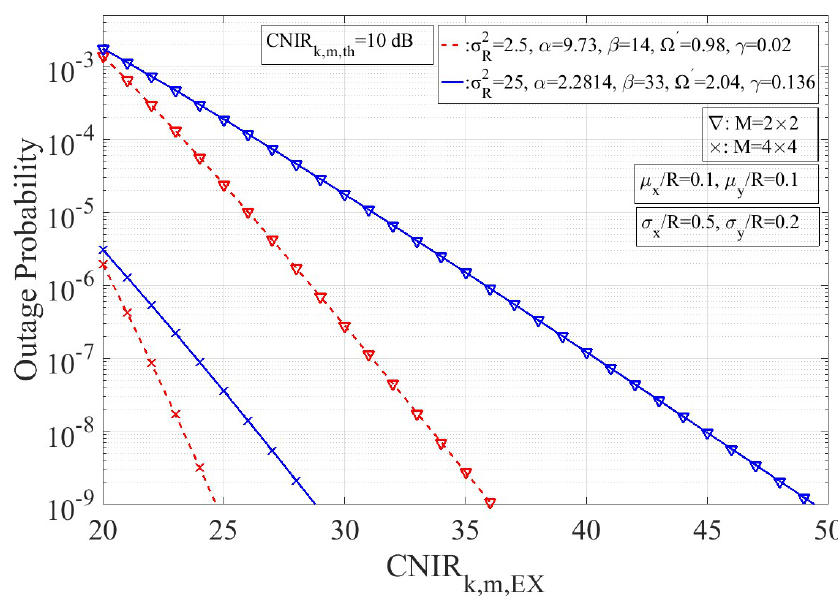
Figure 7. The OP for the CDMA RoFSO link with receivers’ diversity for both directions, over strong turbulence and weak PE impact as a function of the CNIR k,EX per branch.